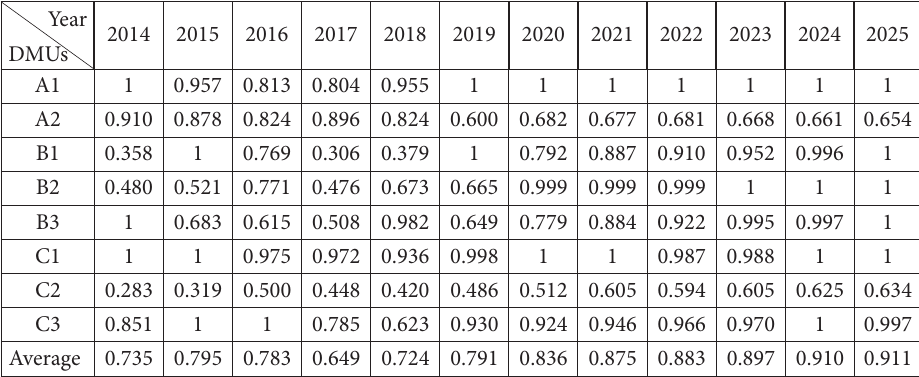
Table 5. Variation on performance across a period of 12 terms (source: compiled by the author)